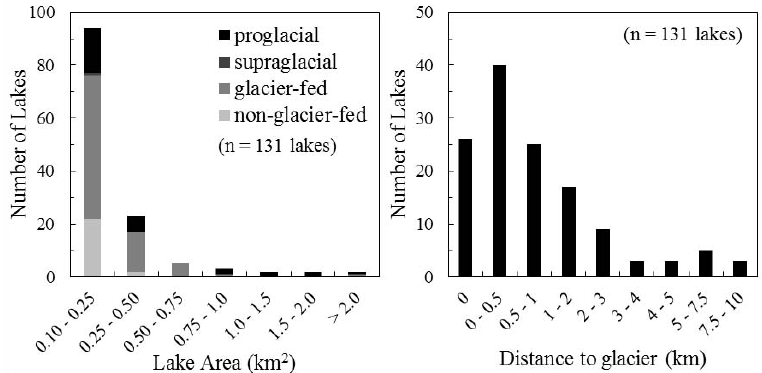
Figure 3. Distribution of lake size according to lake type and the distance to glacier for all lakes in Nepal.